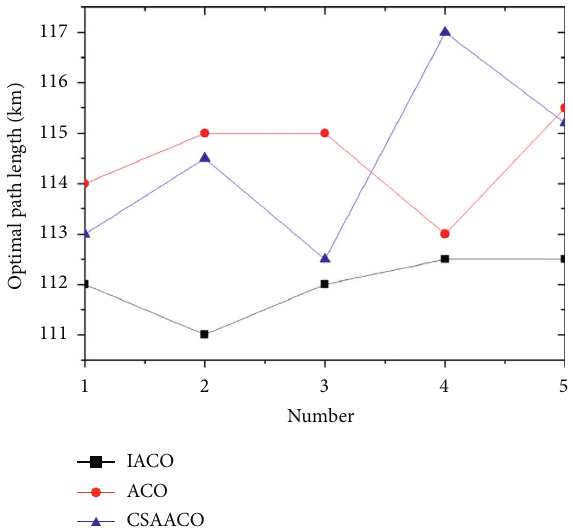
Figure 4: Comparison of iteration times of optimal logistics distribution path.